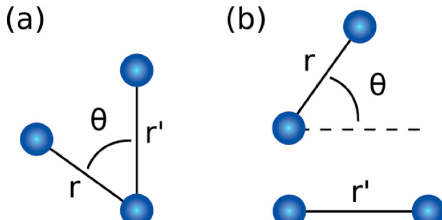
Figure 1 Atom combinations that contribute to the real-space correlation function (cid:2) ð r ; r 0 ;(cid:2) Þ with three atoms ( a ) and four atoms ( b ). The four-atom contributions are insensitive to the separation between the two pairs of